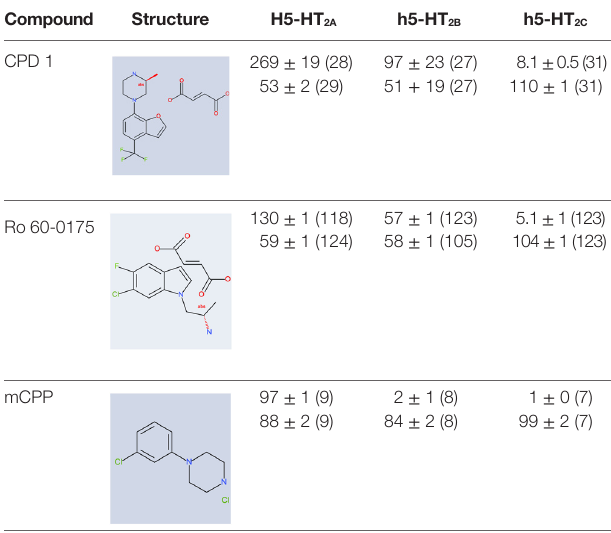
TaBle 2 | Potencies and efficacies of three 5-hT 2c receptor agonists in a gTPgs functional assay using human recombinant cell lines. compound